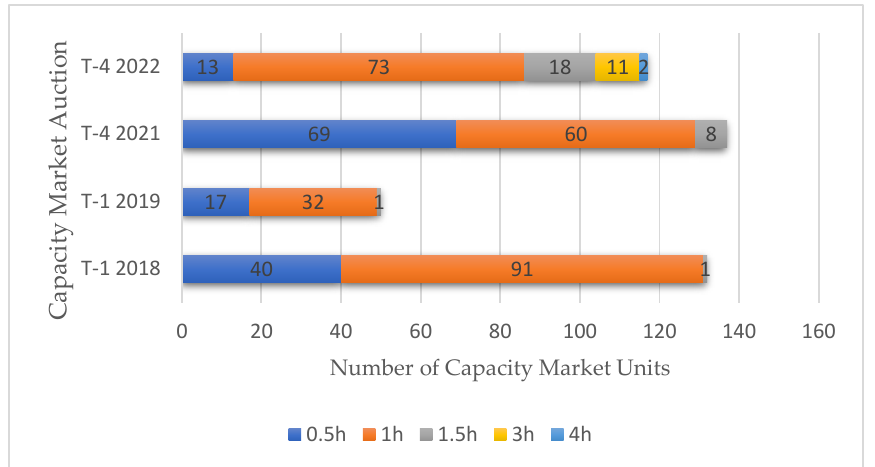
Figure 4. The number of batteries participating in the UK’s capacity market from T-1 2018 to T-4 2022 as reported in the CM register (adopted from [98]).